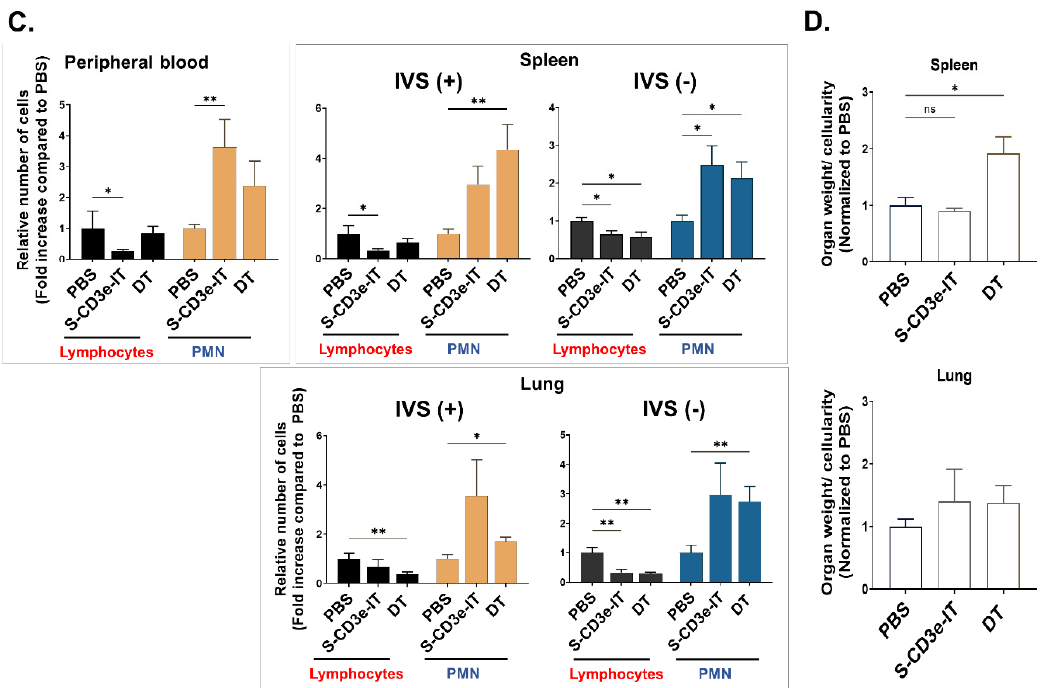
Figure 6. ( A ) CD4iDTR transgenic mice expresses diphtheria toxin receptors (DTRs) on the surface of CD4+ and CD8+ T cells ( -i- ). The right box shows treatment and analytic strategies. Mice were treated with S-CD3e-IT or DT twice daily for four consecutive days and subjected for intra vascular staining and euthanasia on Day 7. ( B ) CD3+ cells are shown for the peripheral blood (absolute number per 1 µ L blood), IVS − spleen (absolute number per whole spleen), IVS − lung (absolute number per whole lung), IVS − bone marrow (absolute number per right femur) and mesenteric LNs (% in CD45.2+ leukocytes). ( C ) Lymphocyte and PMN population changes in the vasculature (IVS+) and in the tissue parenchyma (IVS − ). The total numbers of IVS+ or IVS − lymphocytes (black bars) and PMNs (orange bars for IVS+ PMNs and blue bars for IVS − PMNs) per organ were divided by those of the PBS control (y-axis: fold increase compared to PBS). IVS+ or IVS − lymphocytes and PMNs are shown side-by-side for the peripheral blood, spleen, and lungs separately. ( D ) The ratios of organ weight to total cell count recovered from the organ (W/N ratios) are shown for the spleen ( upper panel ) and lung ( lower panel ). (* p < 0.05 and ** p < 0.01; n = 8 for PBS, n = 11 for DT; n = 6~7 for